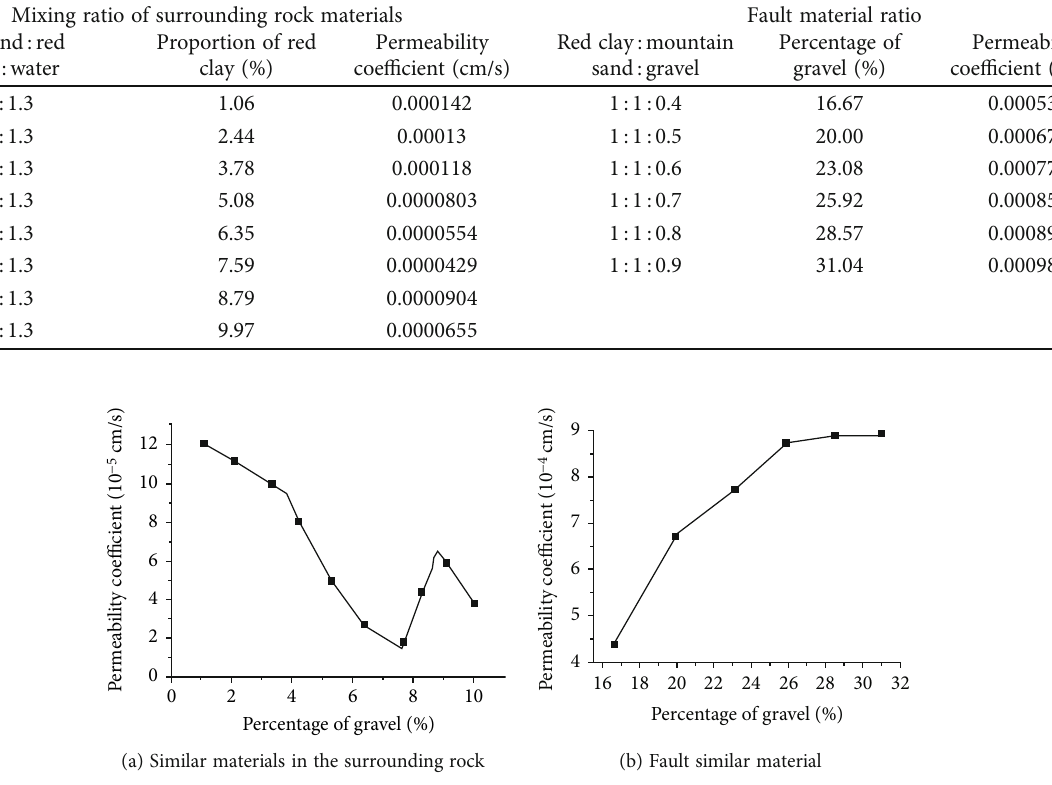
Figure 5: Test values of permeability coe ffi cients of similar materials with di ff erent